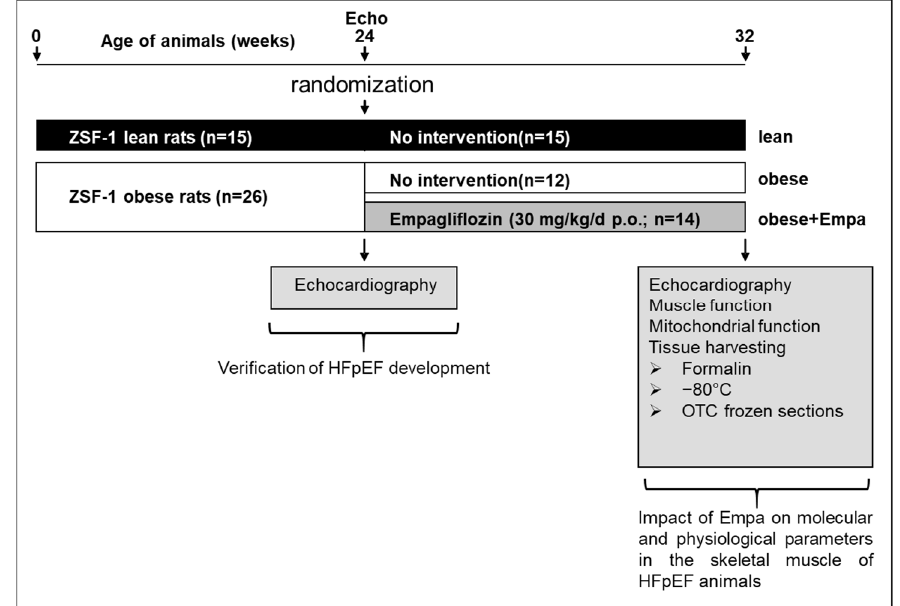
Figure 8. Study design. A schematic drawing of the study design is depicted. ZSF1-lean ( n = 15) and ZSF1-obese ( n = 26) were included into the study. At the age of 24 weeks, after the development of signs of HFpEF, ZSF1-obese animals were randomized into two groups either receiving no inter- vention ( n = 12) or Empa (30 mg/kg/d p.o.) for 8 weeks. At the end of the study echocardiography (Echo) was performed and skeletal muscle tissue was harvested for physiological and molecular analyses. Echo = echocardiography.